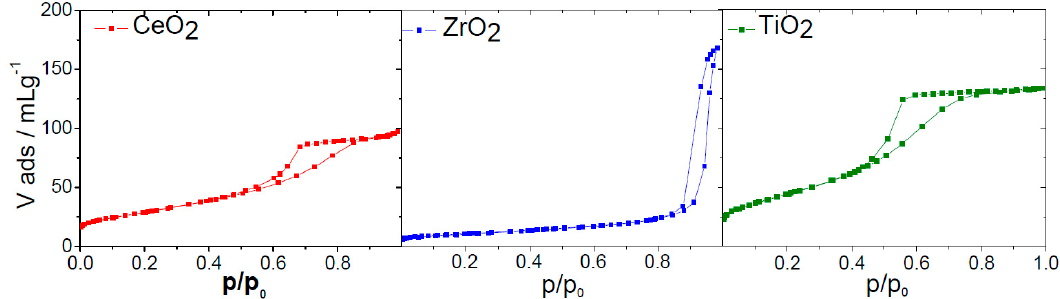
Figure 1. Adsoption—desorption isotherms for the three supports.